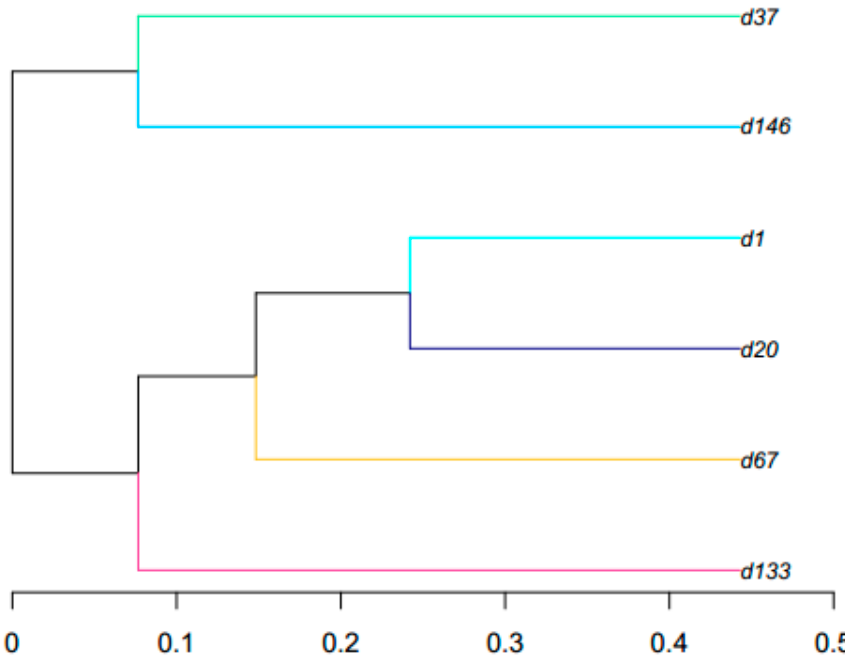
Figure 4. Bray-Curtis tree based on the 97% similarity of the OTUs.